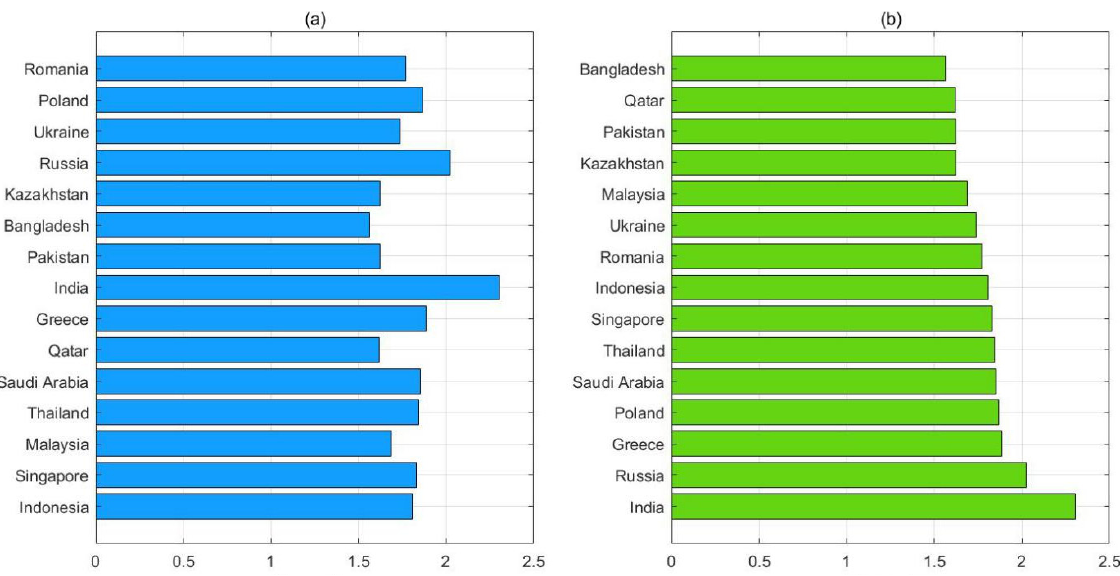
Figure 2. Results of eigenvalues. Note: ( a ) shows the disordered eigenvalues; ( b ) shows the ranking results.